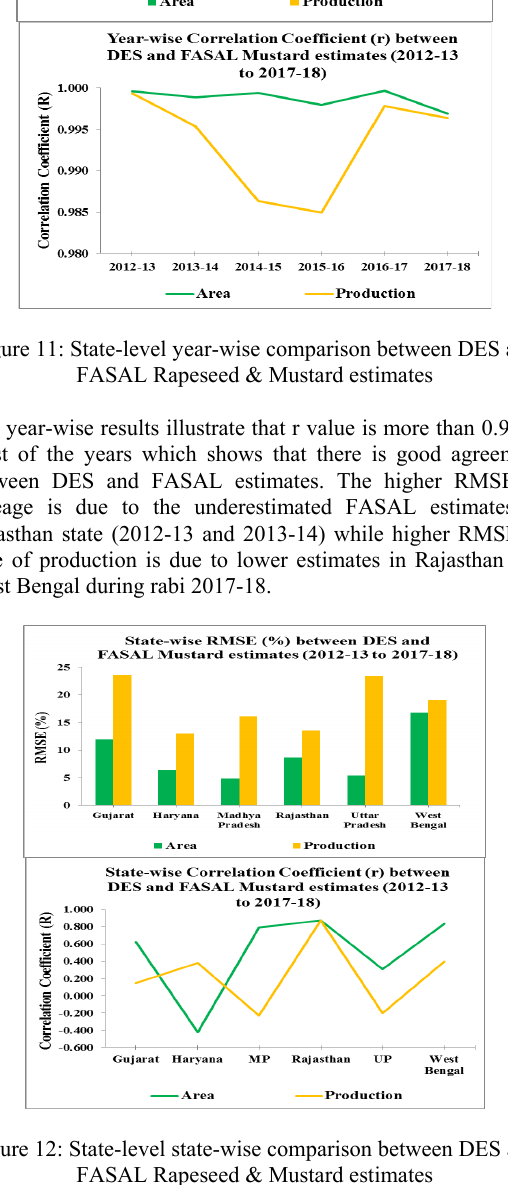
Table 3. Accuracy Assessment of R&M crop classification